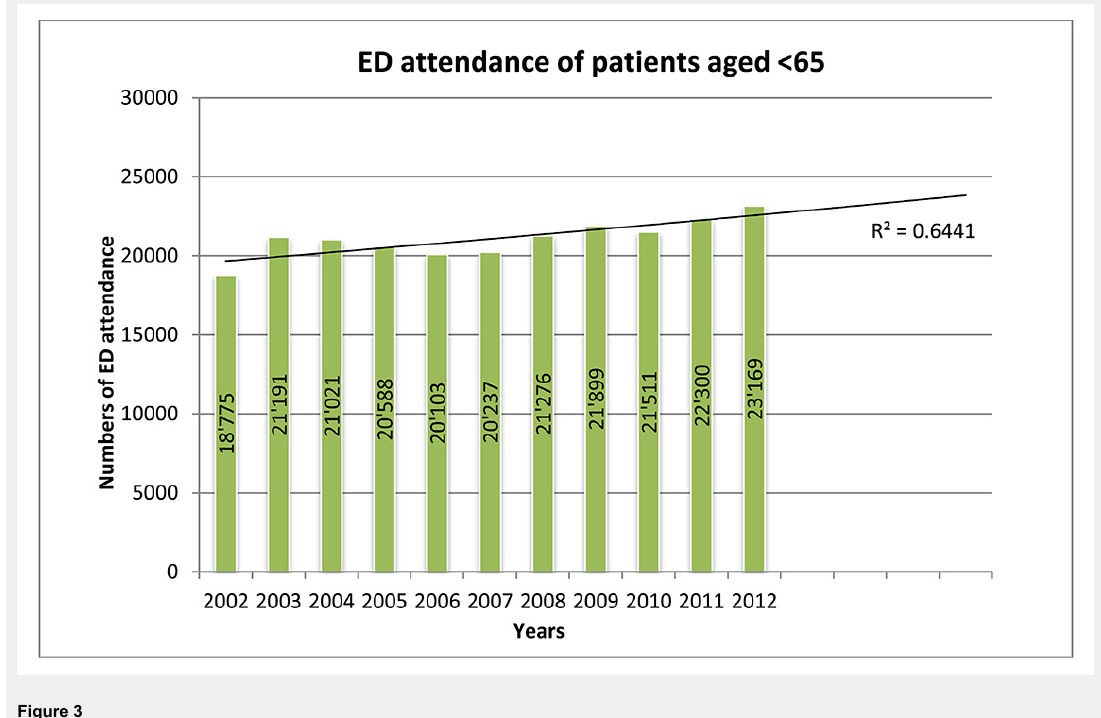
Figure 3 Trend of emergency department (ED) visits of patients aged less than 65 years. The development of the ED attendance of patients <65 years is provided. The line represents the trend of an exponential regression with the calculated coefficient R 2 = 0.6411of ED attendance of this patient group based on the existing data. The group of patients <65 years will continue to grow, but less so than the patients ≥65